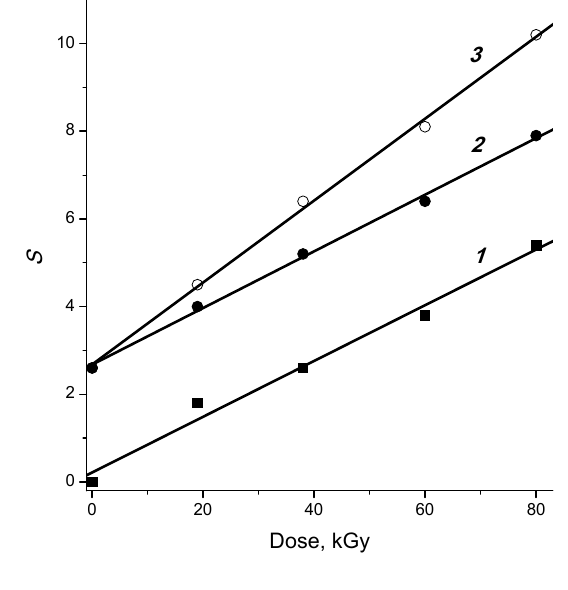
Figure 5. Dependences of the number of bond cleavages ( S ) on the dose for radiolysis of wood cellulose at various combinations of radiation and heating (3 h at 190